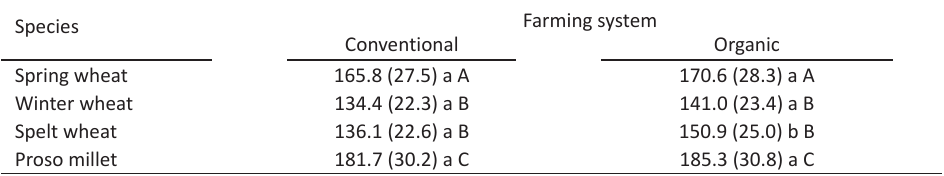
Table 3. Total dietary fiber (TDF) content in cereal grain (g kg -1 ) —mean for 2011-2013 Species